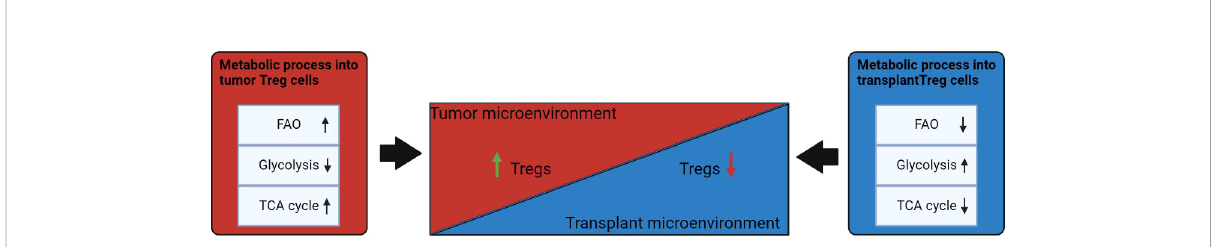
FIGURE 3 In fl uence of the microenvironment on the metabolism of Treg cells. Under conditions of TME, FAO and TCA cycles are increased in Tregs. In the transplantation microenvironment, Treg has a reduced fatty acid metabolism and a transition to glycolysis uptake of alternative energy sources. Events that induce differentiation into Treg cells are highlighted in green; processes that are inhibited in Treg cells are marked in red. ↑ : metabolic processes that are upregulated in Treg cells under the in fl uence of microenvironmental factors; ↓ : metabolic that are downregulated in Treg cells under in fl uence of microenvironmental